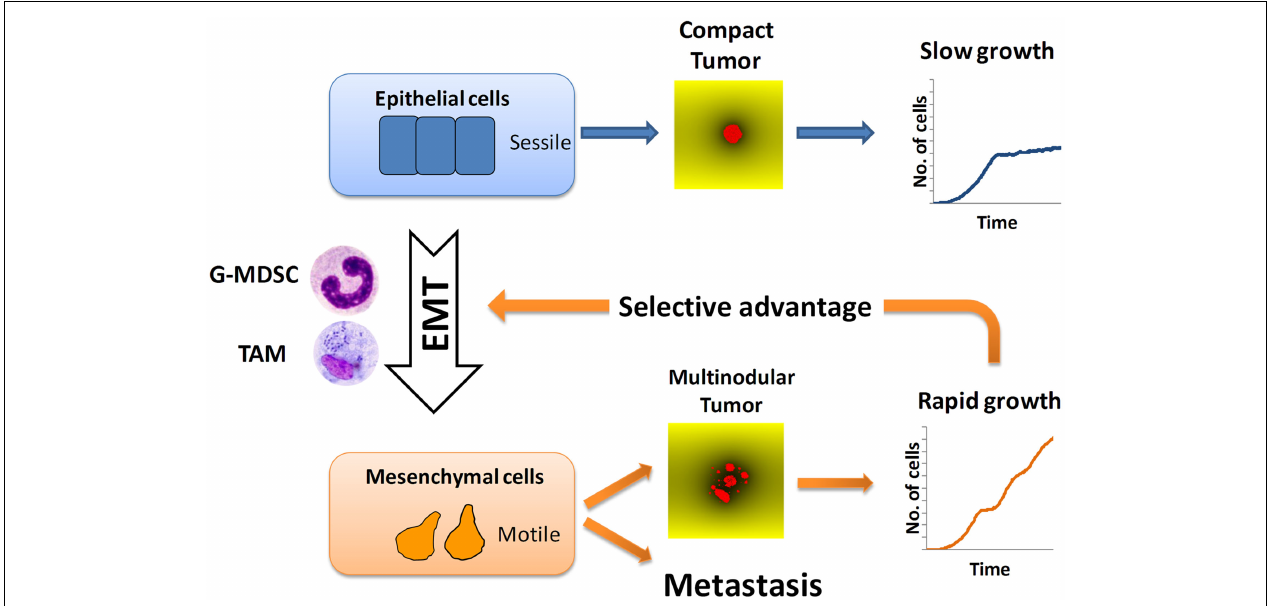
growing tumors with multinodular morphology.This growth advantage explains the superior aggressiveness of multinodular tumors. It also predicts that, under conditions of limited access to nutrients, cancer cells with strong metastatic propensity will be